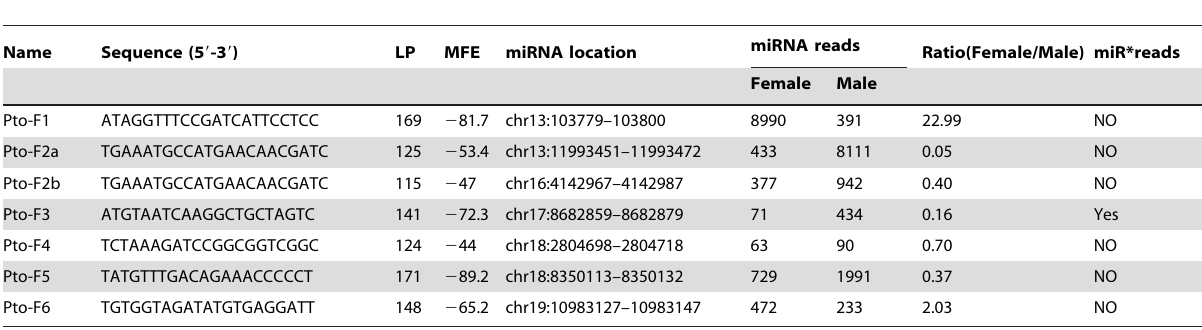
Table 3. Summary of common novel miRNAs in female and male flower libraries.